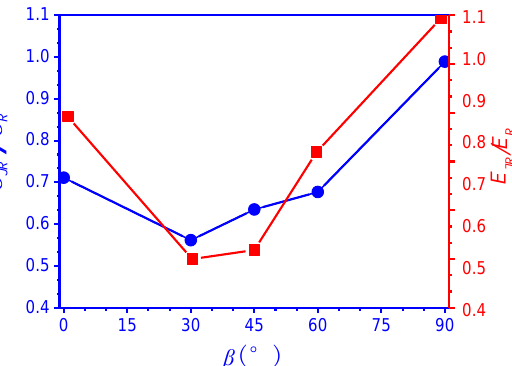
Figure 6. Variations in 𝜎 𝐽𝑅 /𝜎 𝑅 and 𝐸 𝐽𝑅 /𝐸 𝑅 with increasing joint inclination angle ( β ).